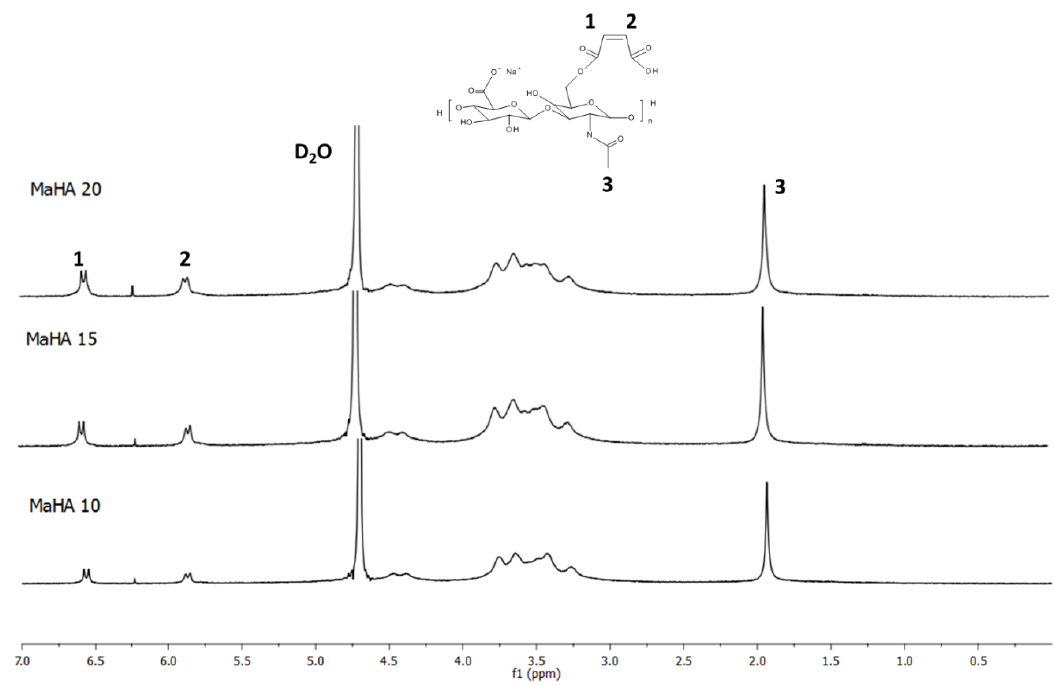
Figure 1. The 1 H-NMR spectra of MaHA-based polymers with different degree of substitution (DS).